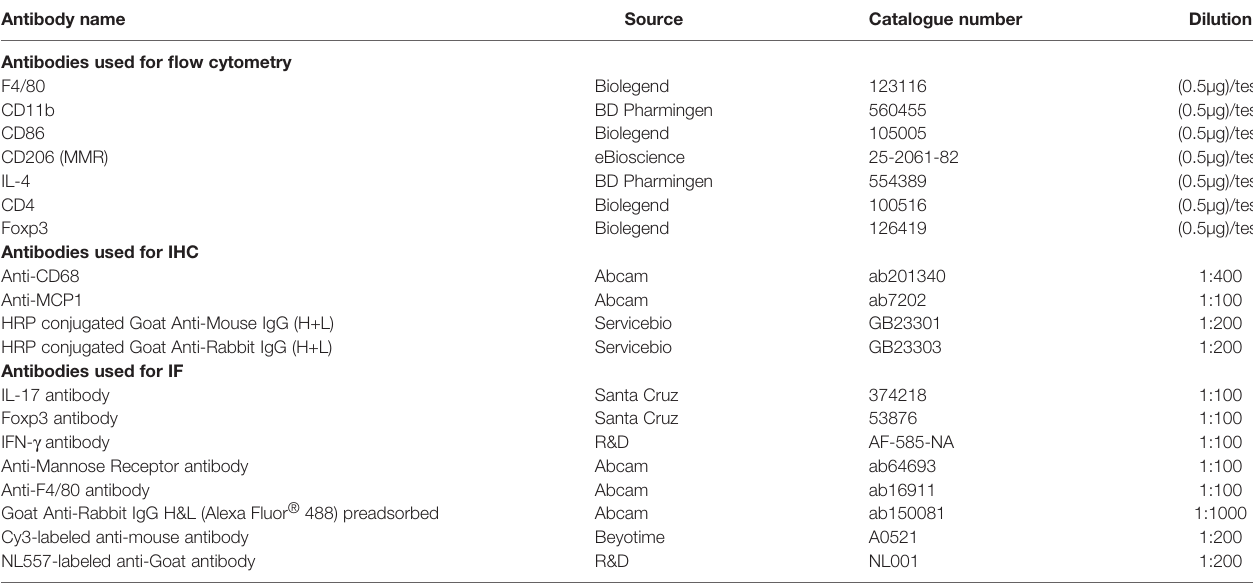
TABLE 1 | Antibodies used for fl ow cytometry, IHC and